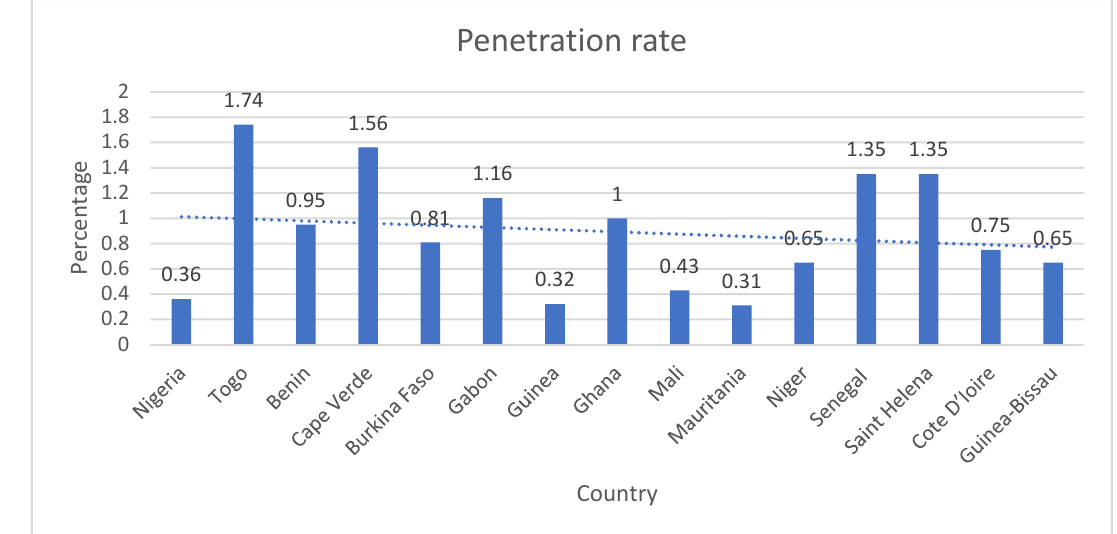
Figure 2. Insurance penetration rate in West African Countries. Source of data: Re Swiss 2018 (https://www.swissre.com/ institute/, accessed on15 February